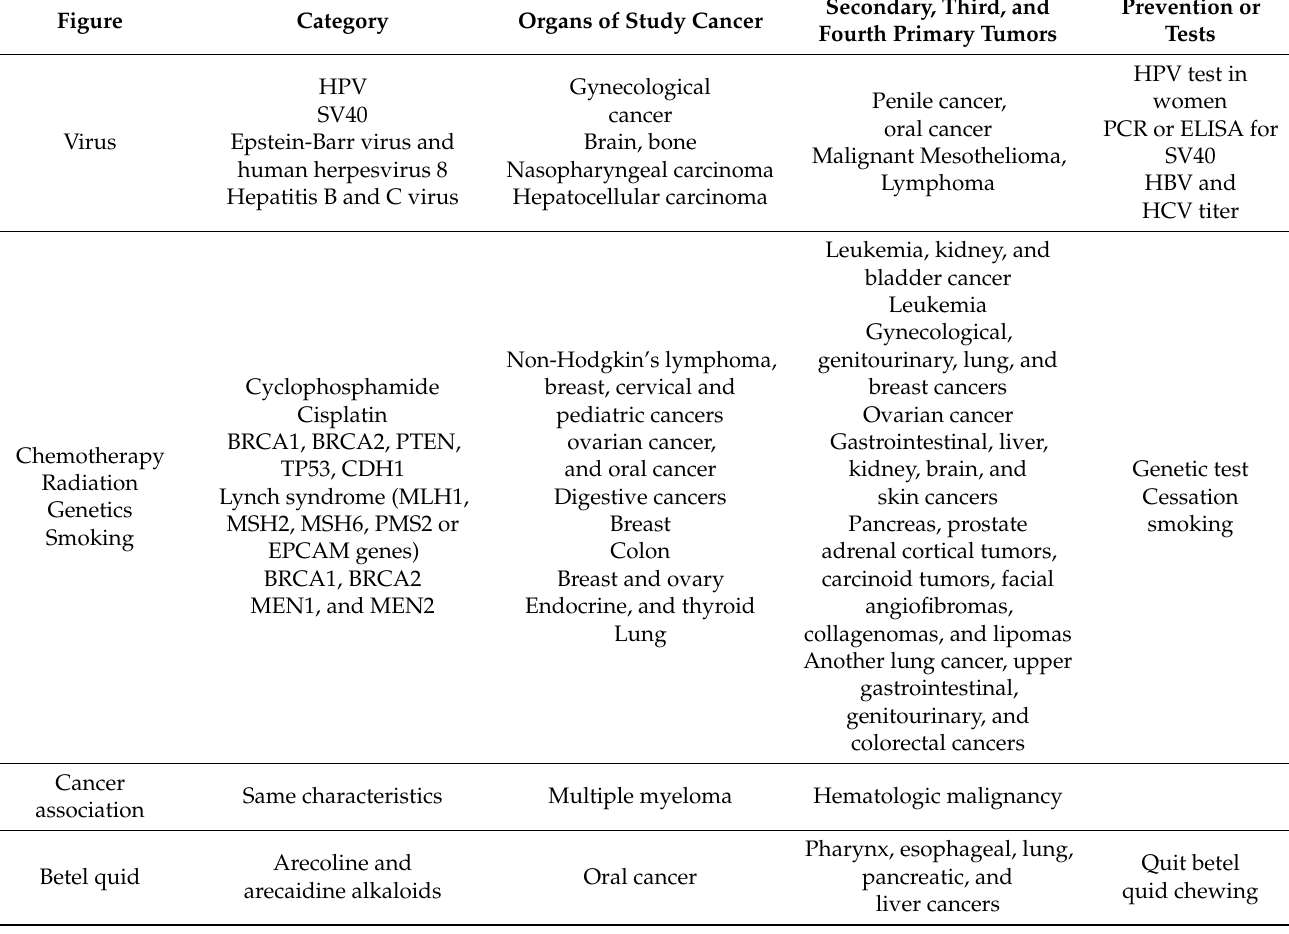
Table 1 summarizes the risk factors associated with multiple primary malignancies. Table 1. Risk factors associated with multiple primary tumors. Secondary, Third, Figure Category Organs of Study Cancer